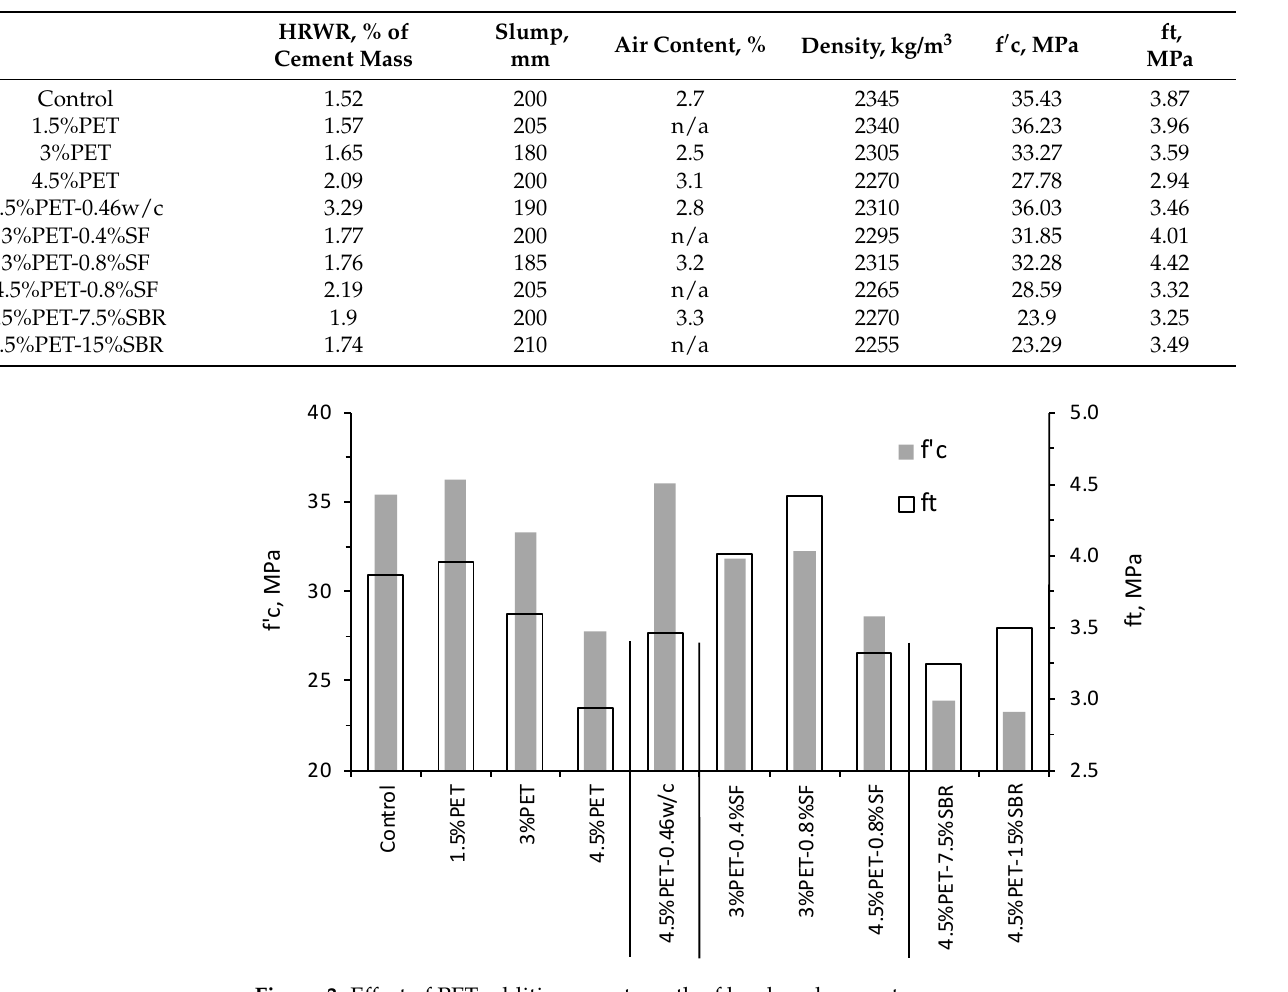
Figure 3. Effect of PET additions on strength of hardened concrete.